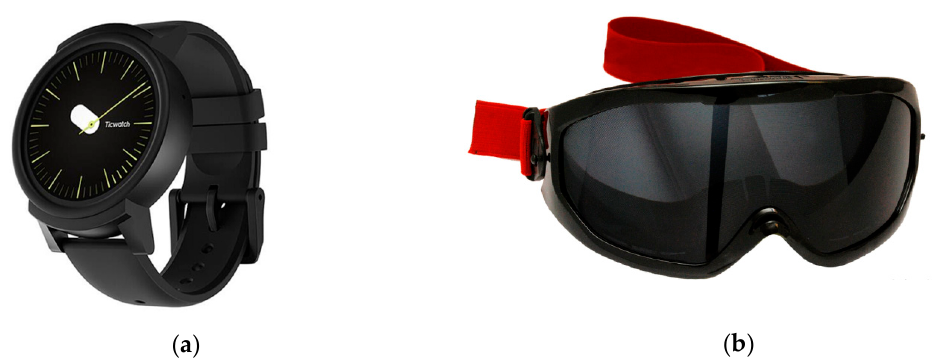
Figure 1. Equipment for data collection. ( a ) Mobvoi TicWatch E; ( b ) impairment glasses.